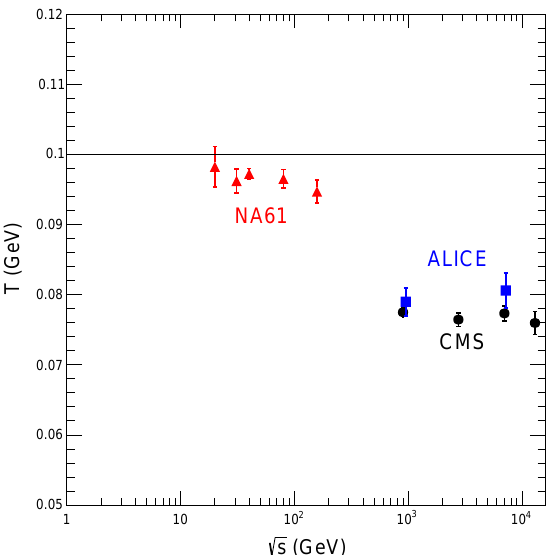
Figure 3. The energy dependence of the temperature T for pions in pp collisions. The triangular points are values of T extracted from data in pp collisions obtained by the NA61/SHINE [14] Collaboration for pions (see Table 5). The squares are the T values in Tables 2 and 3. All points were obtained by fits using Equation (2). The straight line at T = 0.1 GeV is there to guide the eye